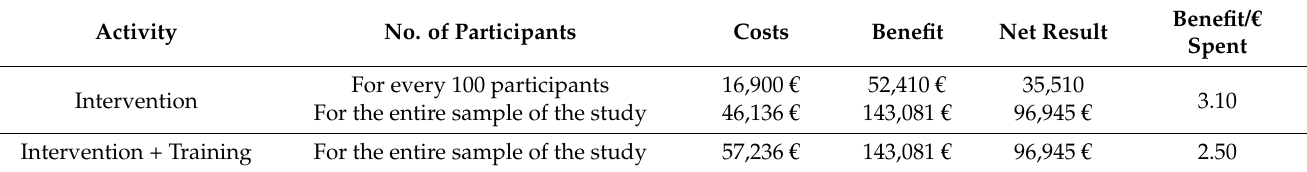
Table 6. Cost-benefit analysis of the intervention program.